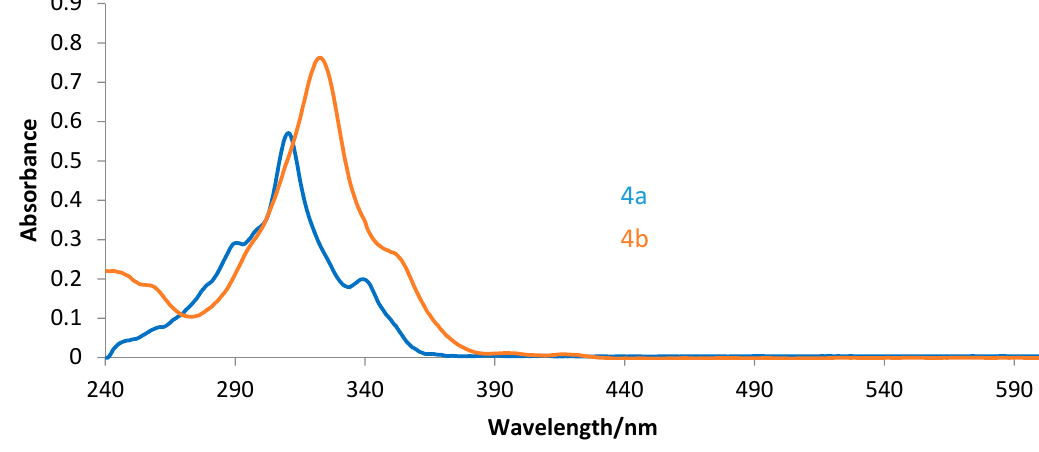
Figure 5. UV-Visible absorption spectra of molecules 4a and 4b .